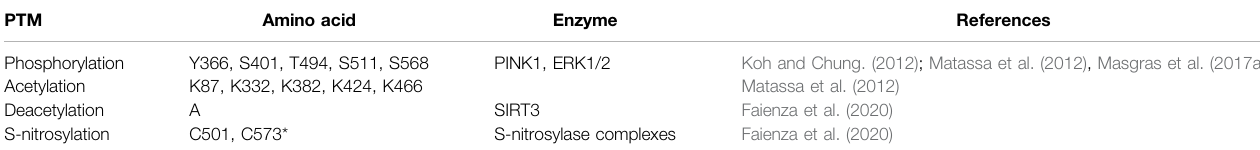
TABLE 1 | Posttranslational Modi fi cations (PTMs) of TRAP1. The different known PTMs for TRAP1. PTMs marked with a star* still need to be validated. PTM